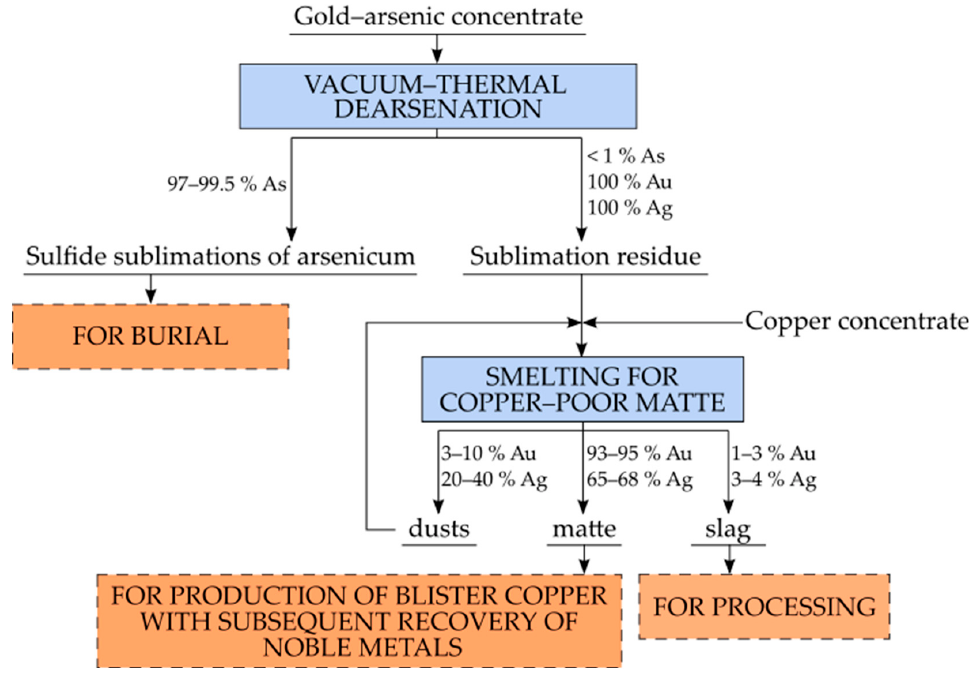
Figure 1. Proposed processing scheme for gold-arsenic concentrates with indication of arsenic and noble metal distribution in the processing products. noble metal distribution in the processing